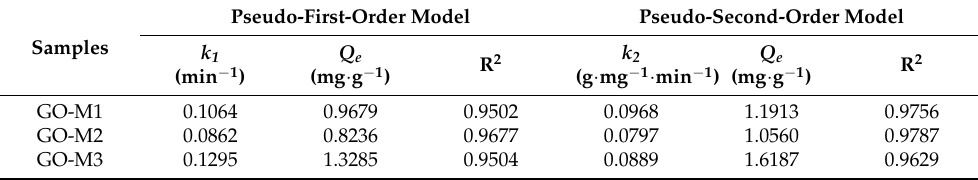
Table 5. Calculation parameters of kinetics for the adsorption of Cr(VI) on GOs.